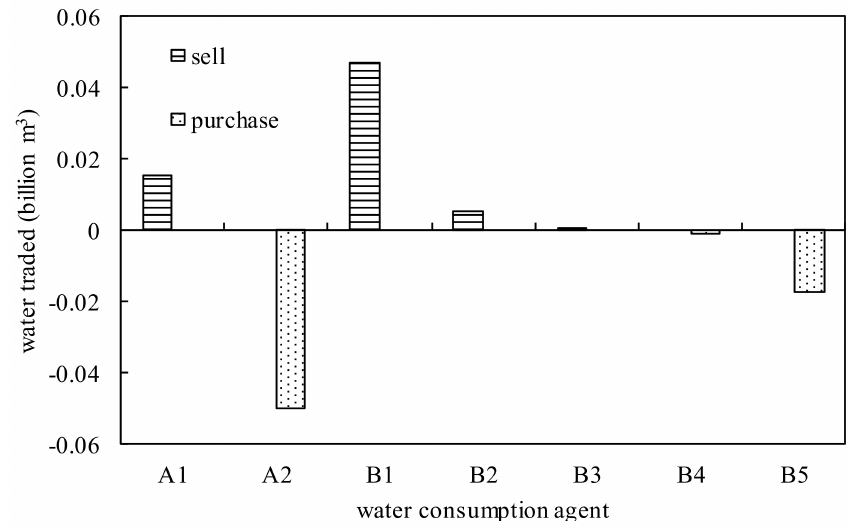
Figure 5. Initial water right trades by various agents in the water market in